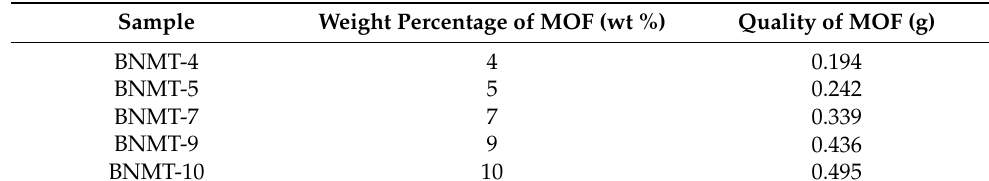
Table 2. The list of the samples to be studied.